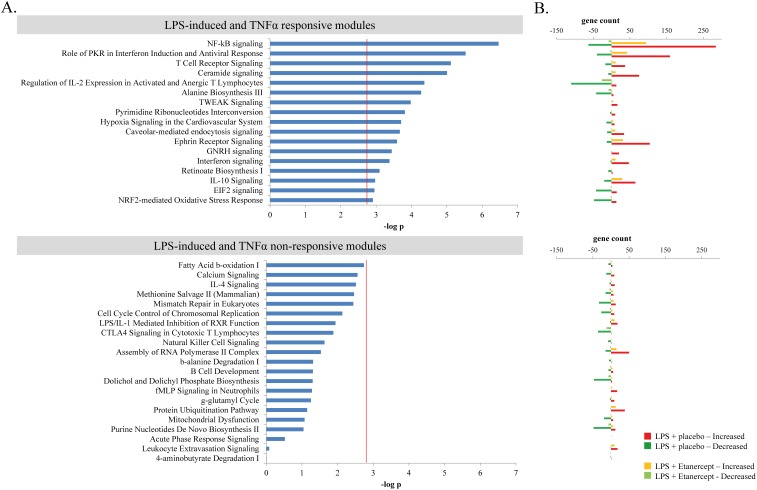
LPS-induced TNFα responsive and non-responsive transcriptional module delineation by weighted correlation analysis.Each transcriptional module, encompassing highly intercorrelating transcripts, was represented by its first principal component across all samples (module eigengene). A. Bar plot of module significance for the effect of etanercept on the LPS-response based on unpaired student t statistics of the module eigengene between post-LPS samples from placebo and etanercept-treated subjects. The red line denotes the multiple-test corrected significance threshold (−log10
p = 2.88). B. Bar plot denoting the upregulated and downregulated gene counts per IPA (ww.ingenuity.com) interactome pathway for both the LPS-challenged placebo-treated and LPS-challenged etanercept-treated samples.